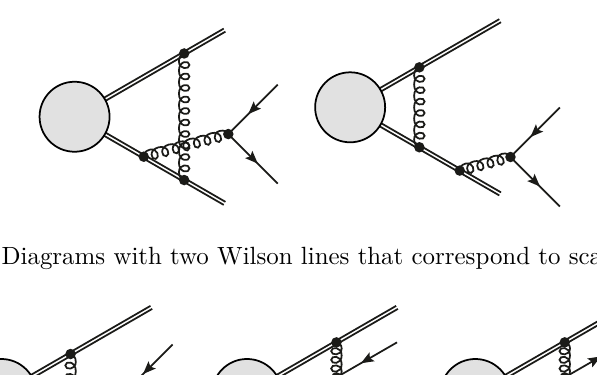
Figure 11 . Remaining diagrams with only one Wilson line.